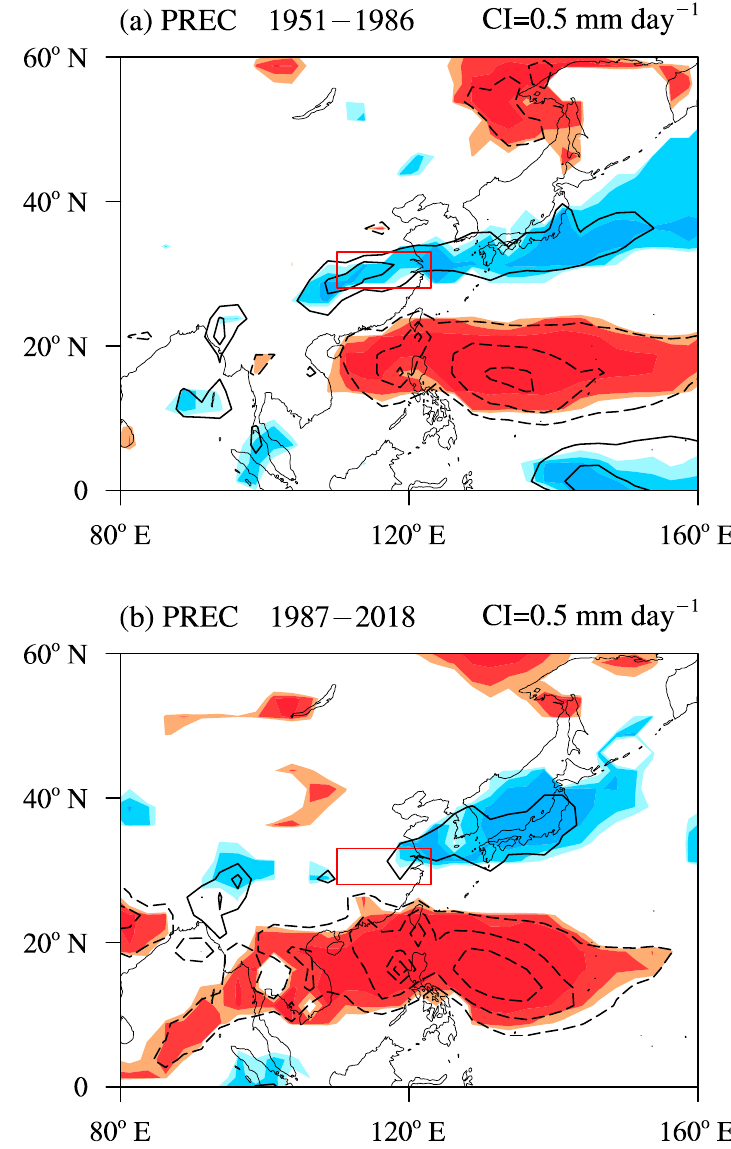
Figure 2. Regression maps of the JJA PREC rainfall (contour; unit: mm day − 1 ) with respect to the normalized EAP index (multiplied by − 1.0) for periods ( a ) 1951–1986 and ( b ) 1987–2018. Positive (negative) values are indicated by solid (dashed) contours with the zero contour omitted. The three orange (blue) shadings from shallow to deep indicate that positive (negative) anomalies are significant at the 90%, 95%, and 99% confidence levels based on a two-tailed Student’s t test, respectively. The red boxes indicate the YH-R basin.